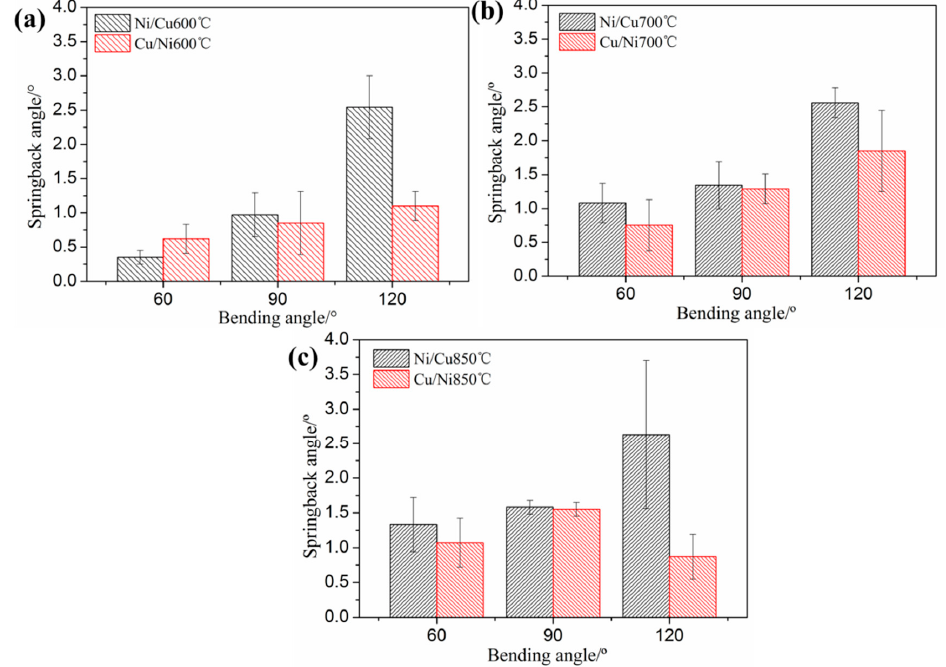
Figure 10. Springback angle for specimens under different placement modes ( a ) annealing at 600 °C, ( b ) annealing at 700 °C, and ( c ) annealing at 850 °C.